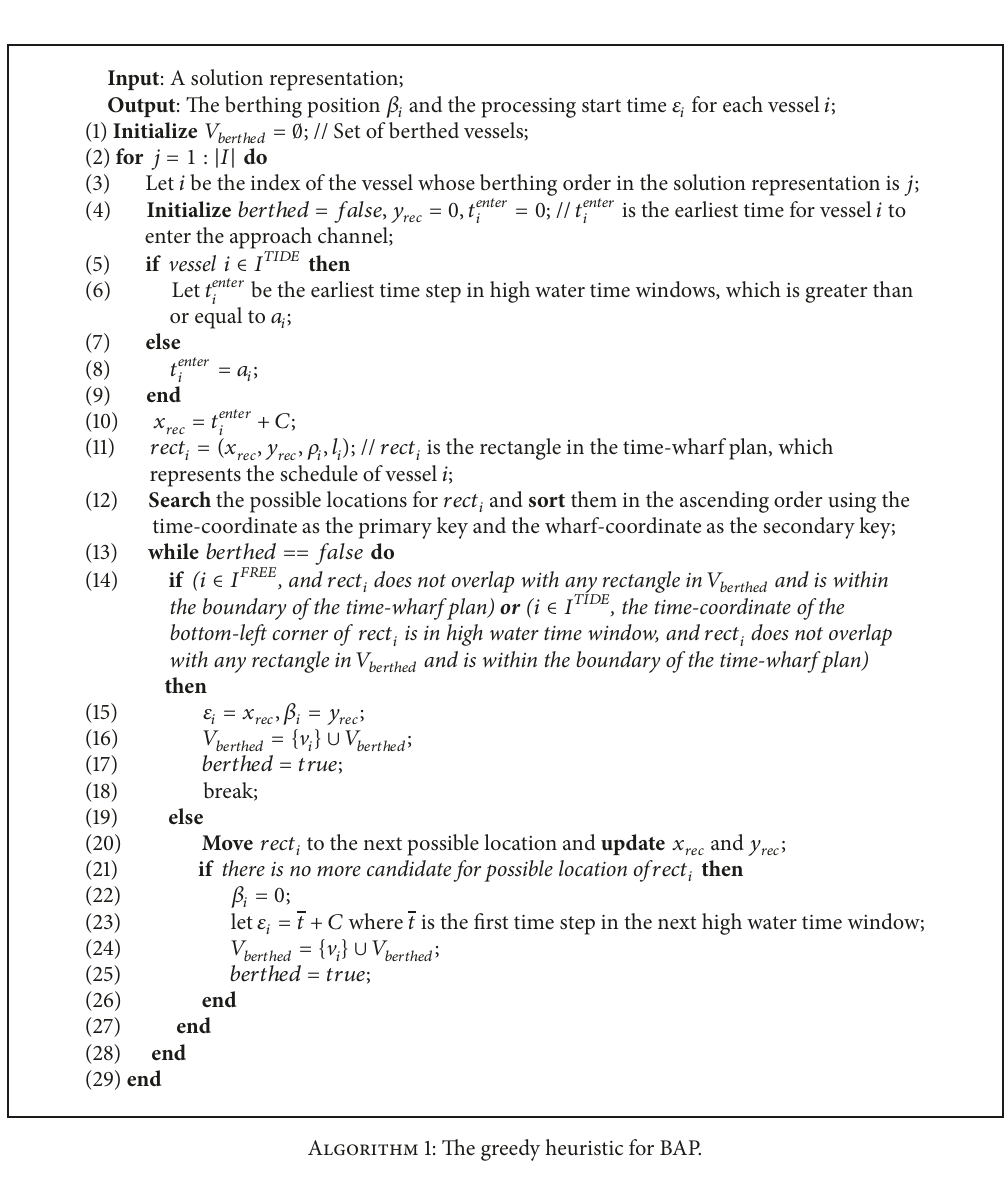
Figure 3: A solution representation for an instance with six vessels.